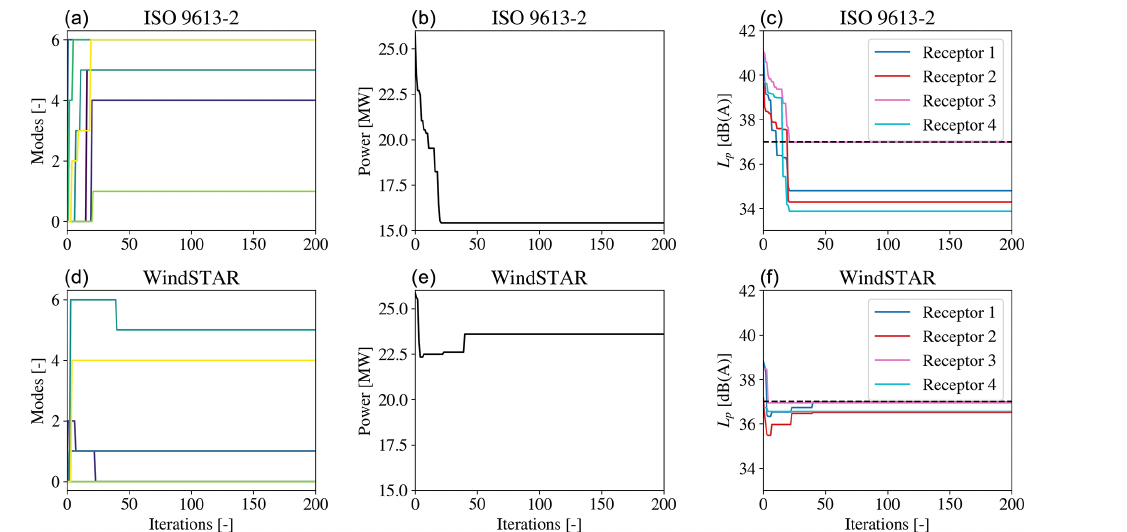
Figure 10. The operational mode, m i , for each wind turbine (a, d) ; the overall power of the seven SWT-DD-142 wind turbines (b, e) ; and the integrated sound pressure level, L p ,j , at each receptor (c, f) during the optimization at θ = 0 ◦ and U hub = 10ms − 1 . The noise constraint is set to L p , lim ,j = 37dB(A) and represented by the dashed line in the right figure.